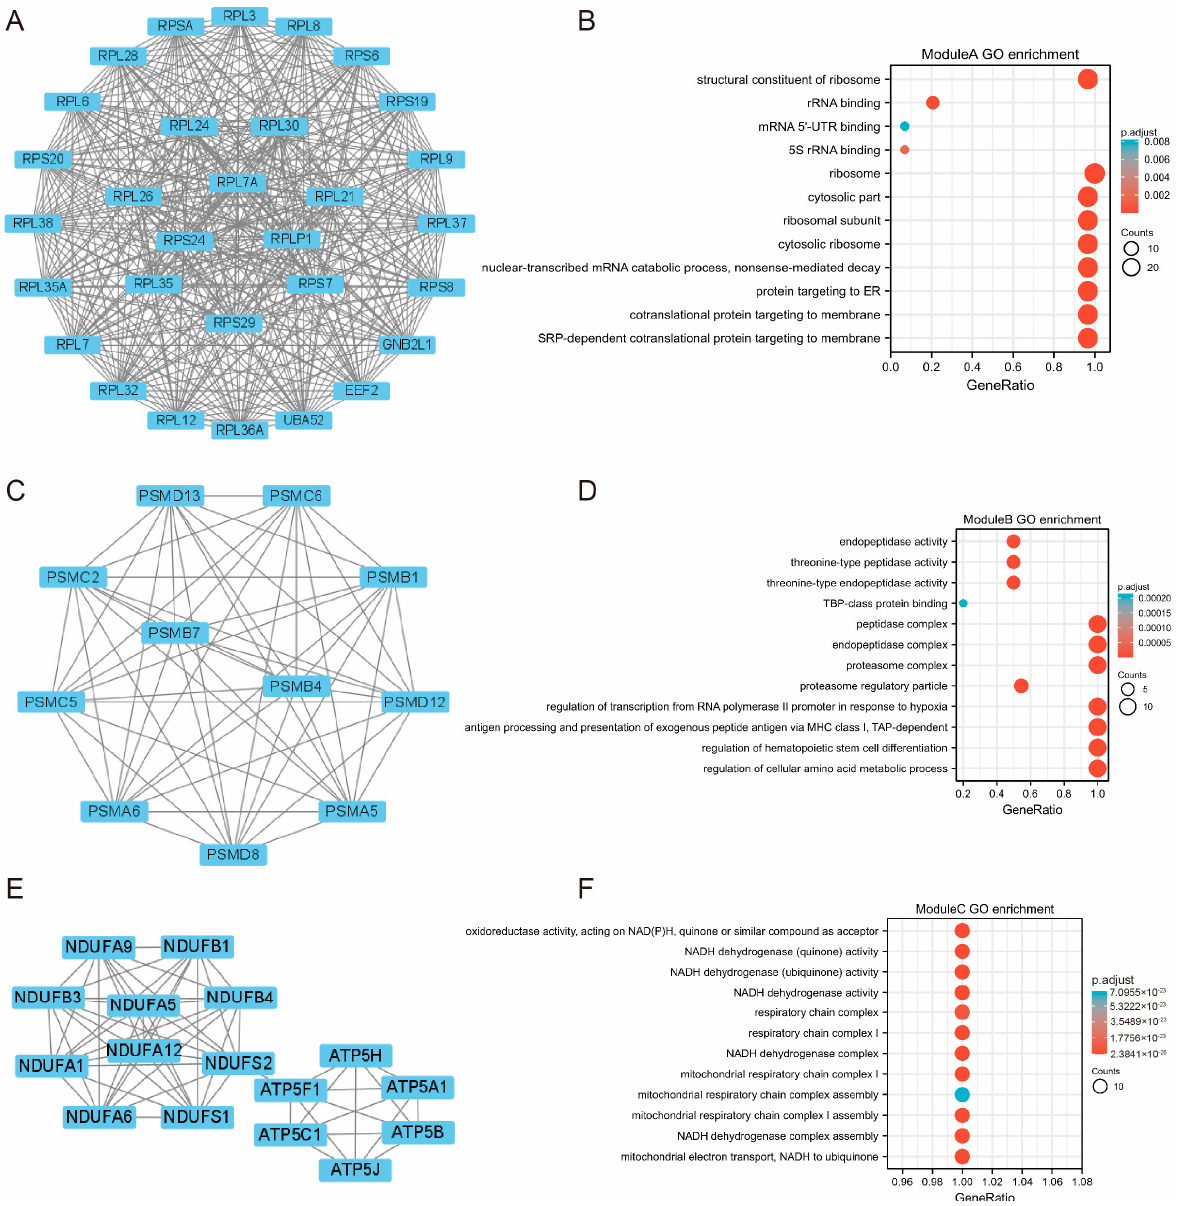
Figure 3. Three Modules Extracted from Protein-Protein Interaction (PPI) Network and GO Enrichment Analysis. ( A ) PPI network of module A. ( B ) Top 12 GO enrichment terms of module A. ( C ) PPI network of module B. ( D ) Top 12 GO enrichment terms of B. ( E ) PPI network of module C. ( F ) Top 12 GO enrichment terms of module C.